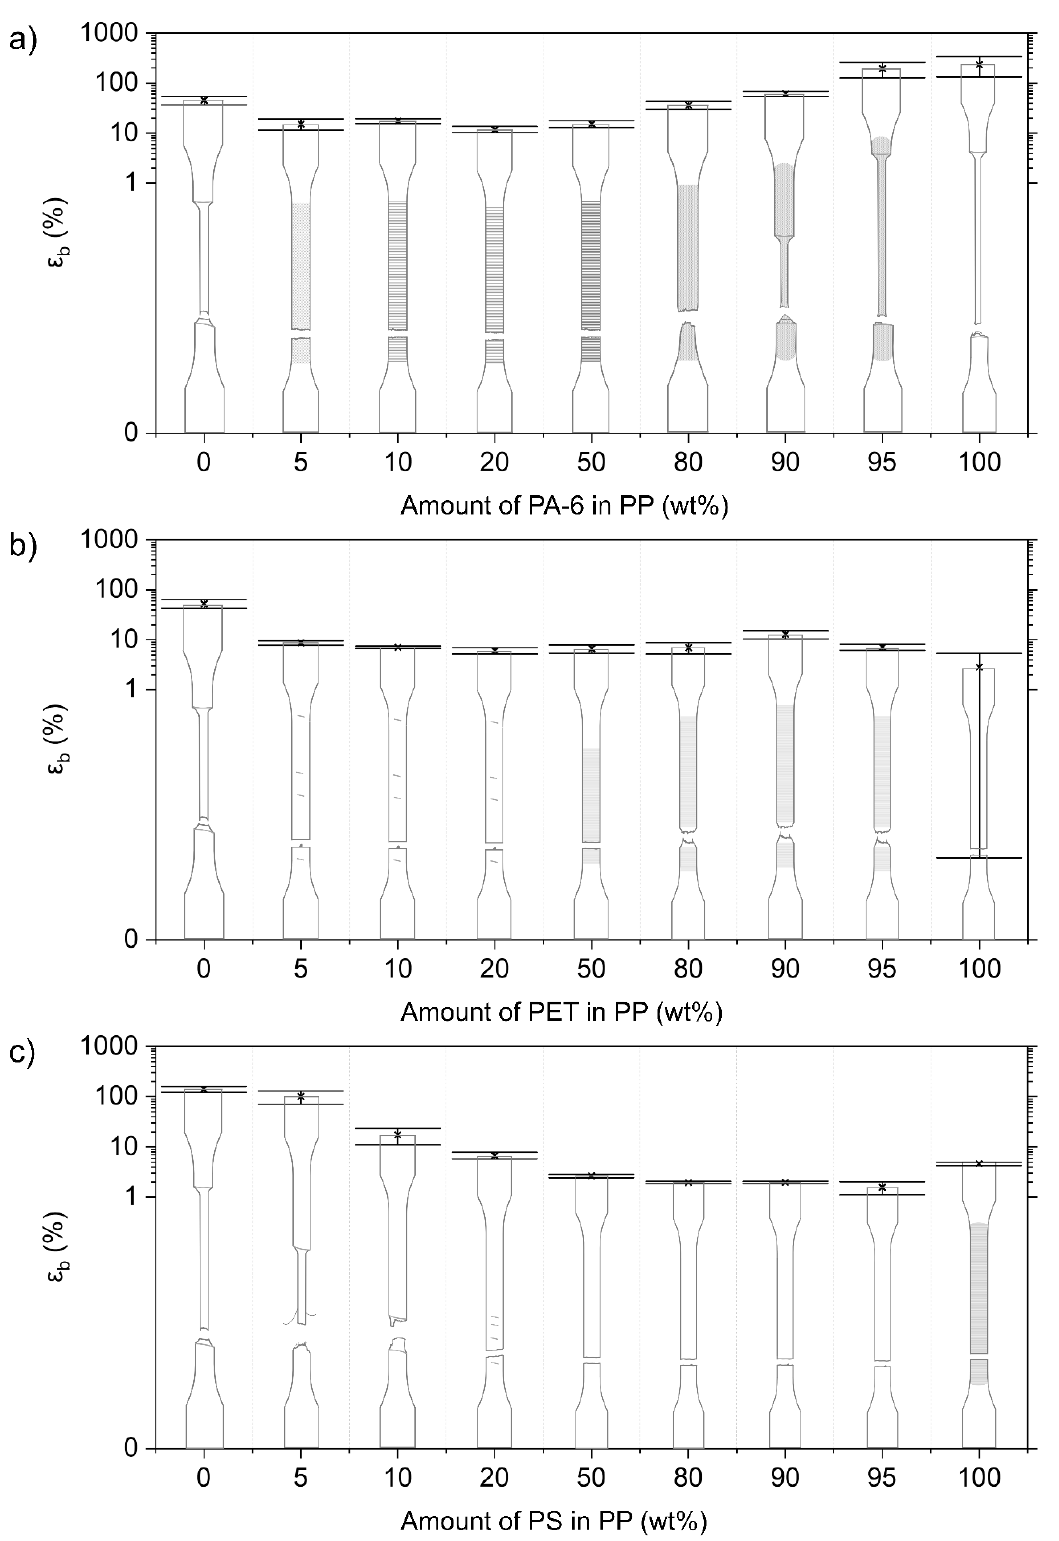
Figure 7. Overview of the deformed samples after tensile testing and respective ε b values for the PP blends combined with ( a ) PA-6, ( b ) PET, and ( c ) PS. Crazing is indicated as fine mark lines for the neat PS. Other shading points to stress whitening, which is visible during/after tensile testing. Coarser markings and lines indicate local points of necking initiation.